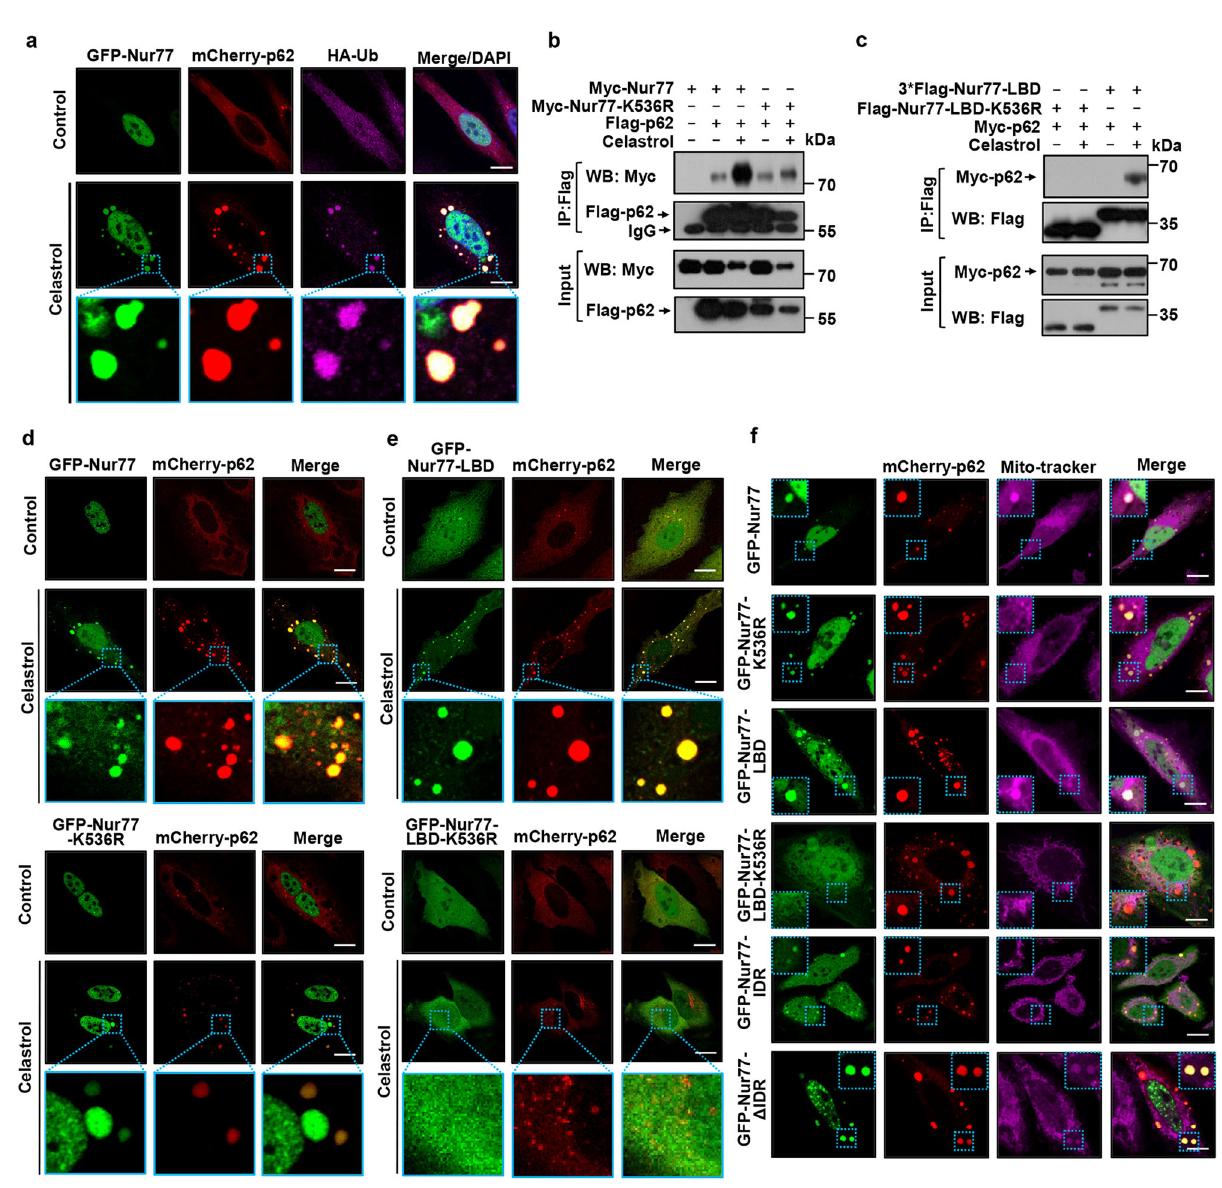
Fig. 5 Ubiquitinated Nur77 interacts with p62 to sequester damaged mitochondria. a Immuno fl uorescence images of GFP-Nur77, mCherry-p62, and HA-Ub transfected in HeLa cells treated with or without celastrol. Data illustrate the colocalization of Nur77 with p62 and Ub in the presence of celastrol. Scale bar, 10 μ m. b , c Interaction of indicated Nur77 or deubiquitinated mutant (K536R) and p62 was analyzed in HeLa cells treated with or without celastrol by co-immunoprecipitation (co-IP) assay. d , e Immuno fl uorescence images showing the effect of celastrol-induced Nur77 ubiquitination on mCherry-p62 droplet formation. Scale bar, 10 μ m. f Representative images showing ubiquitination-dependent colocalization of Nur77 with p62 and mitochondria in HeLa cells treated with celastrol. Scale bar, 10 μ m. Data represent at least three independent experiments. Source data are provided as Source Data fi